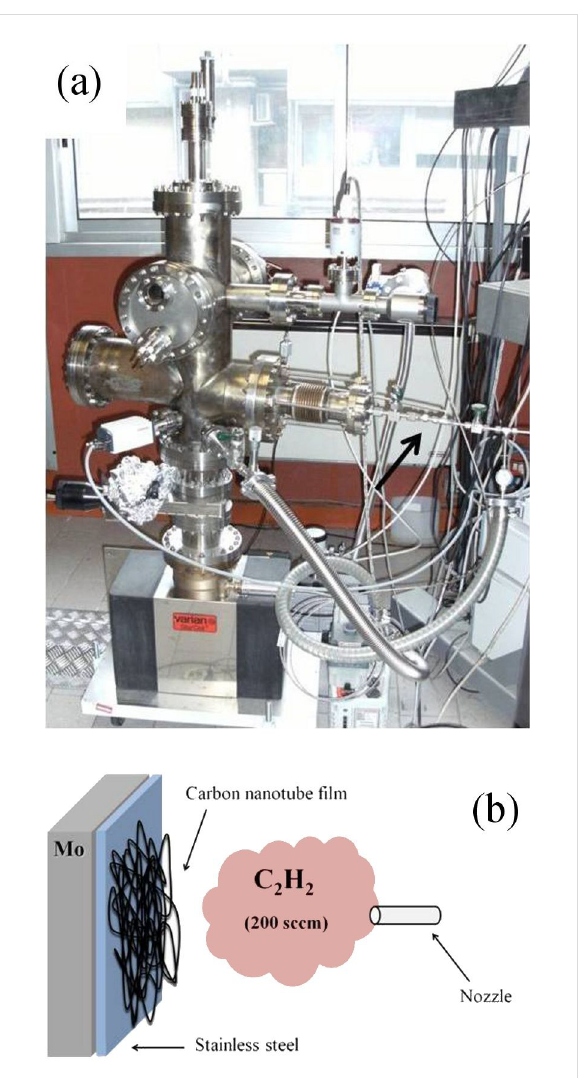
Figure 1: (a) Photograph of the chemical vapour deposition chamber used to synthesize MWCNTs. The reactor comprises an UHV chamber, pumped by an ion pump and equipped with a manipulator capable of reaching temperatures of about 800–900 °C. Acetylene and argon fluxes, introduced in the chamber through the gas line high- lighted by the arrow, are adjusted by means of two suitable valves. (b) Schematics showing the CVD process: The stainless-steel substrate is mounted on a heatable molybdenum sample holder. After a tempera- ture of 750 °C has been achieved, acetylene gas (200 sccm) is inserted through a nozzle in the chamber under an Ar atmosphere.